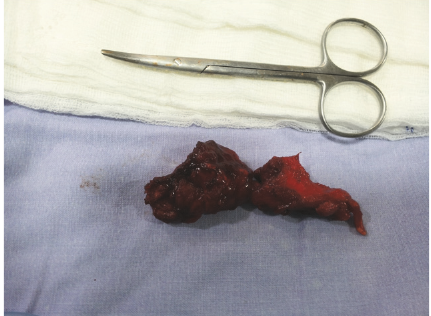
Figure 3: The mesh was fully removed. No sutures were used and the trauma closed only with nylon sutures. The internal scar was kept where it was possible to avoid possible hernia recurrence in the